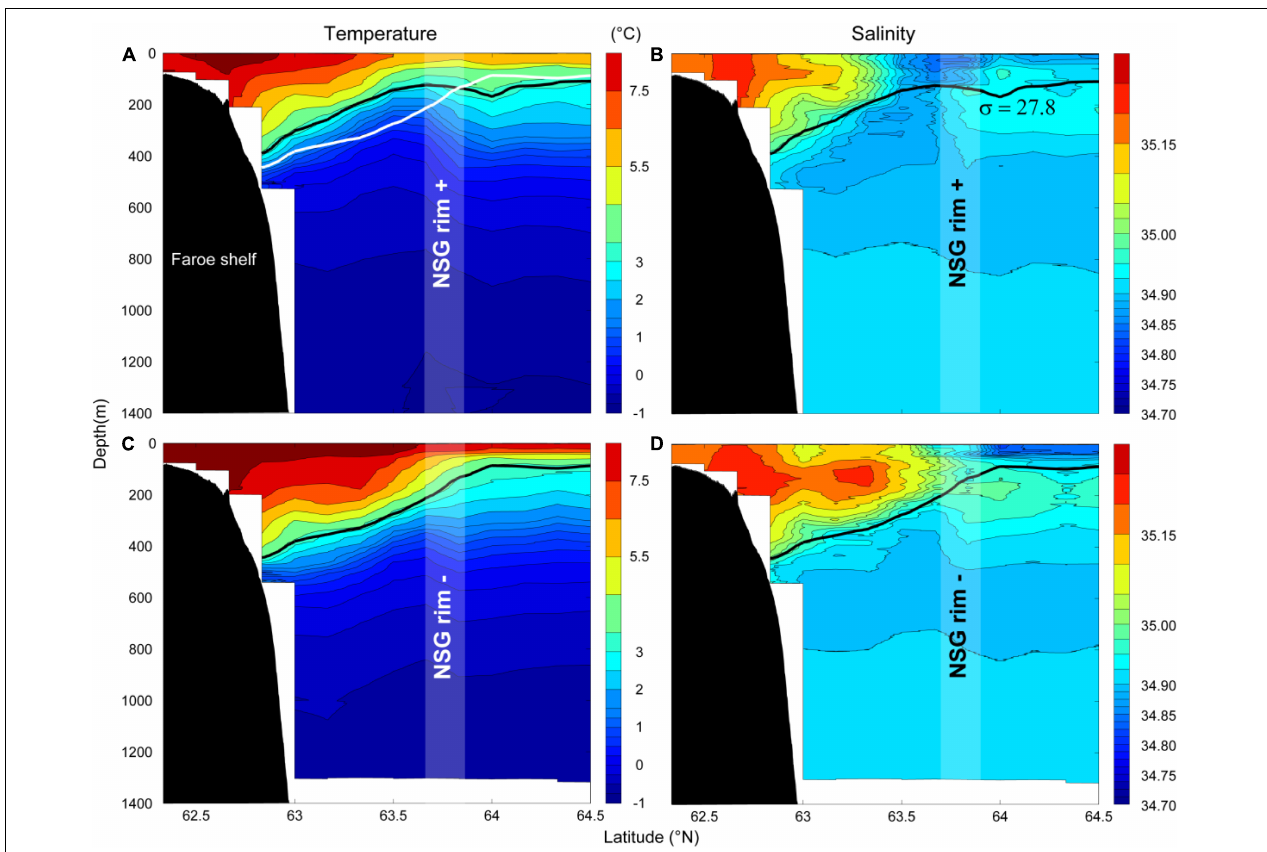
FIGURE 6 | Hydrographic composite sections, contrasting periods with a strong NSG rim (A,B) against periods with a weak NSG rim (C,D) . The states are represented by an average over ten sections with the highest and lowest value of ψ NSG , respectively. Black lines show the position of the σ θ = 27.8 isopycnal ( h 27 . 8 ) during NSG rim+ and NSG rim– states, respectively. The white line in (A) shows h 27 . 8 from (C)